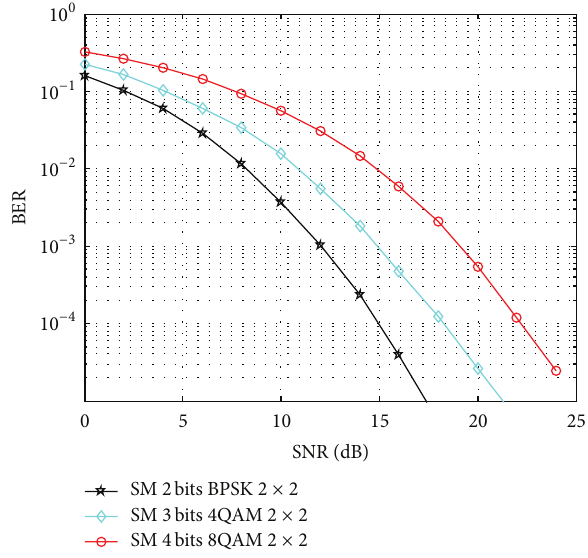
Figure 4: The received SNR versus BER in SM with 3 different modulations. 𝛼 𝑃 𝑐 0.2107 W